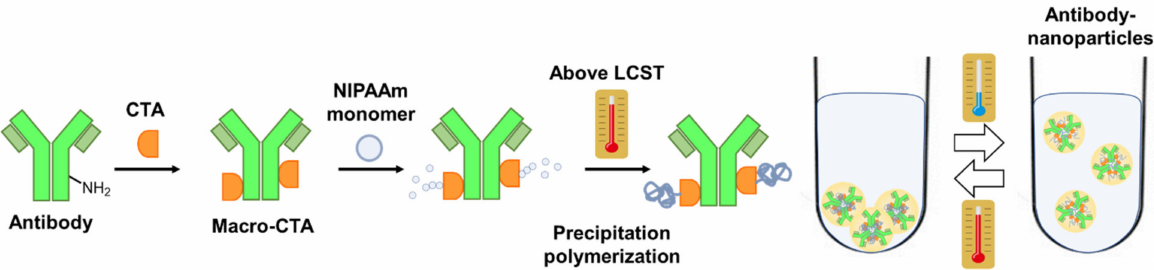
Figure 1. Design concept of the temperature-responsive antibody–nanoparticles prepared using the “grafting from” and “thermal precipitation”